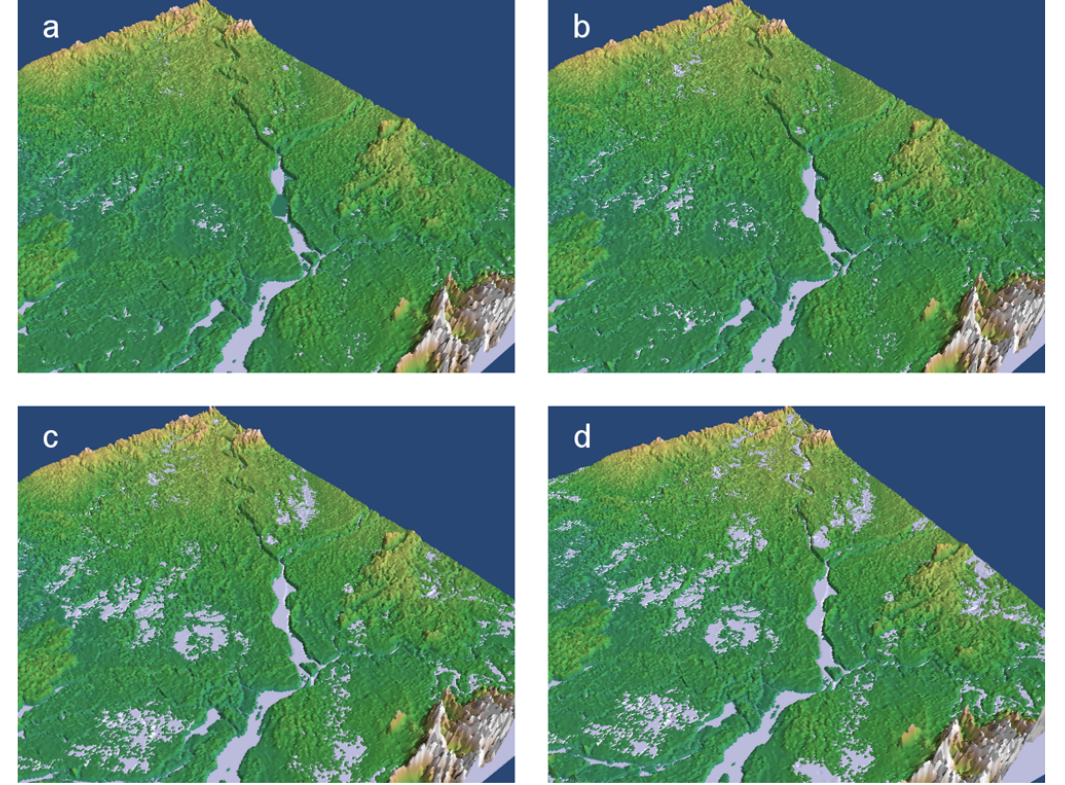
Fig. 2. An illustration of the sequential leveling of river water levels with the surrounding connected pixels over a part of Bangladesh on a 1 × 1km elevation grid. The examples shown here are computed using the once-in-30yr flood from the ERA40/CRU reference scenario; assuming flooding from stream order 6 and higher; a levee height, conform to a recurrence interval of 0yr (i.e. the total volume from DynRout is considered): (a) leveling with 10cm of water, (b) 20cm of water, (c) 2m of water, some areas have stopped filling, (d) 10m of